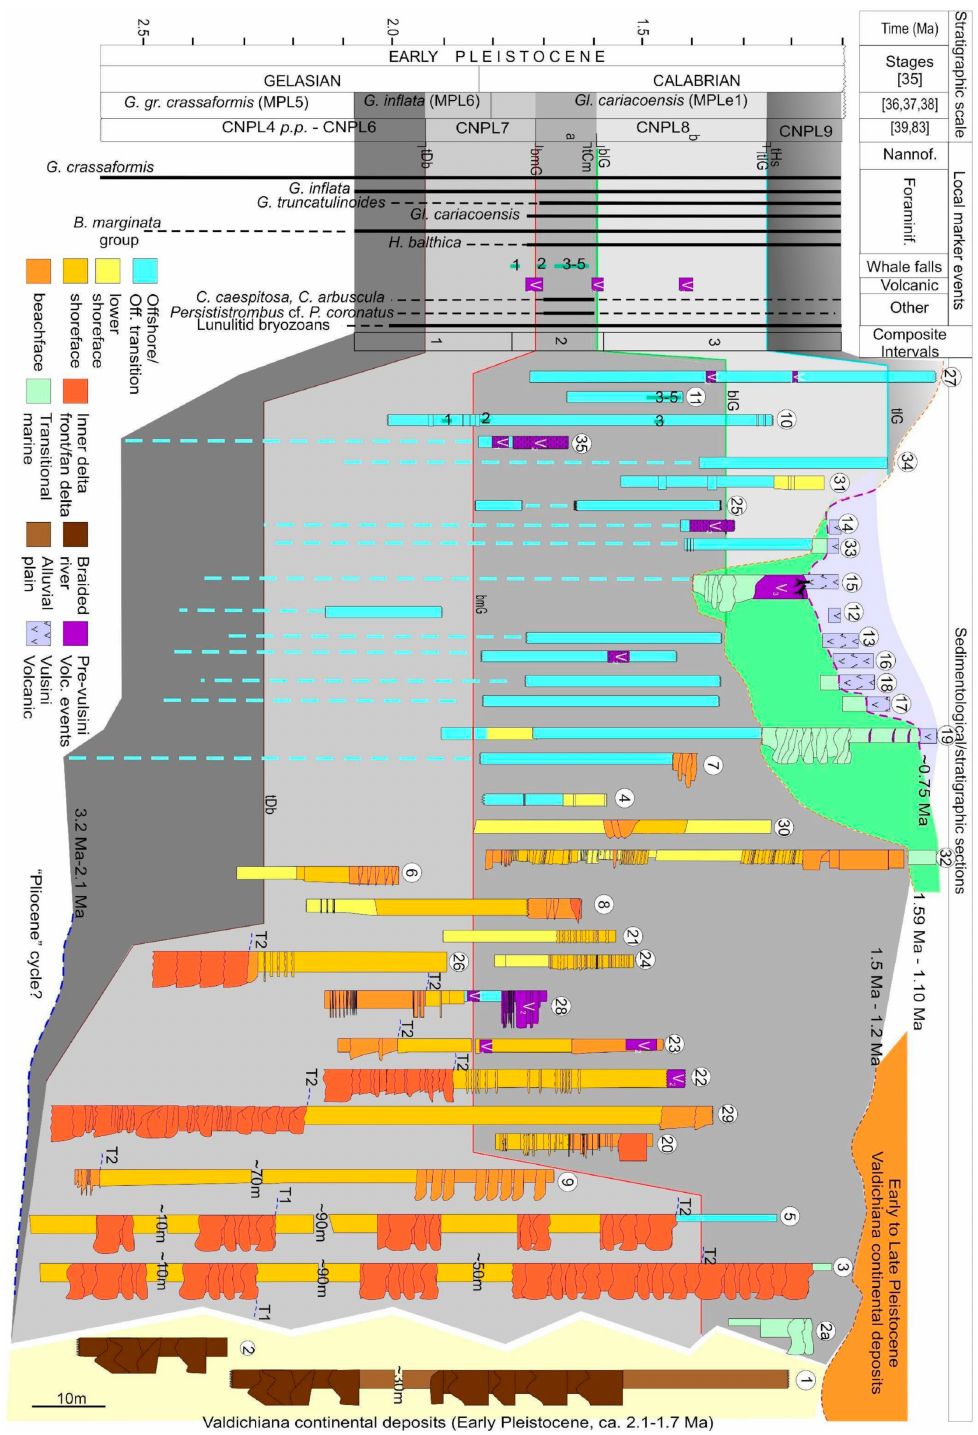
Figure 6. Sedimentological / stratigraphic sections of the Valdichiana Basin (numbers are the same as in Figure